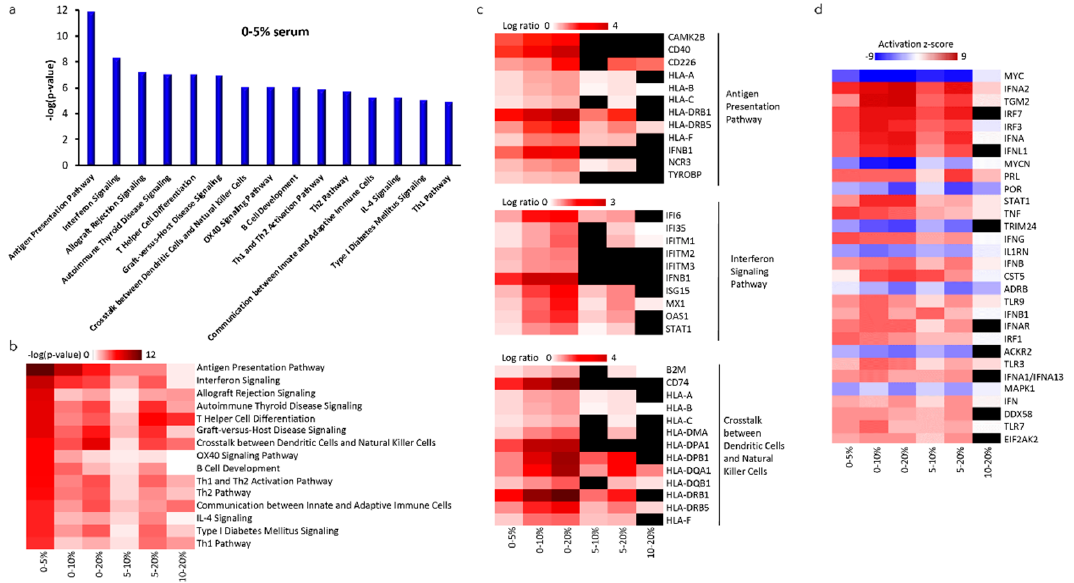
Figure 4. Analysis of gene expression profiles in NK-92 cells exposed to different concentrations of serum. ( a ) Canonical pathway analysis for NK-92 cells exposed to 5% serum compared to cells grown without serum; ( b ) the heatmap shows statistically significant differentially regulated pathways created by comparison of differential gene expression contrasts for contrasts indicated below; ( c ) differential gene expression for pathways related to immune response. Missing values that did not reach statistical significance criteria are shown in black. ( d ) Ingenuity Pathway Analysis (IPA) upstream transcriptional regulator analysis for genes that are found to be differentially regulated in datasets.